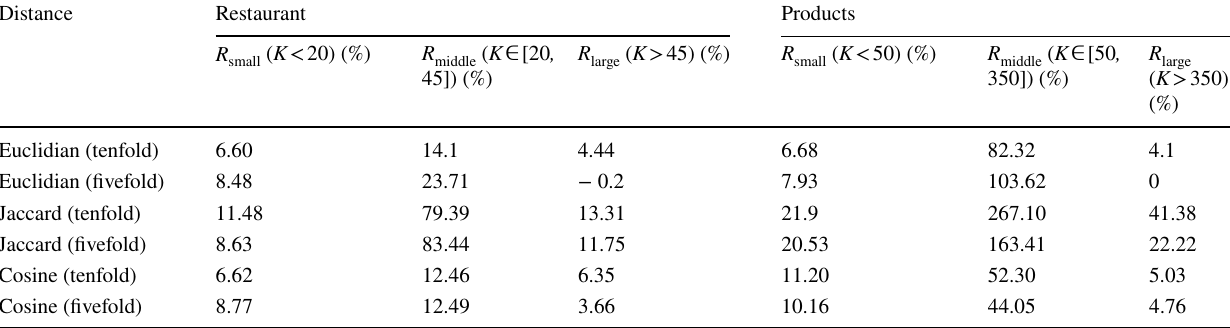
Table 3 Improvement rate averages with respect to three ranges of K values for both datasets and three distances with tenfold and fivefold cross-